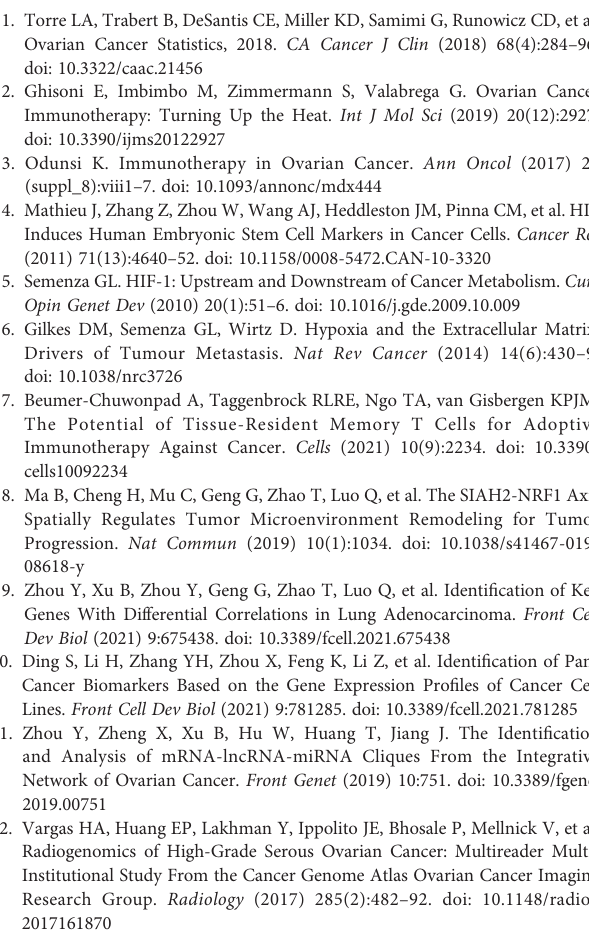
the TCGA cohort. (G) Calibration curve of nomogram for OS prediction at 1 year, 3 years, and 5-years in the GEO cohort. Supplementary Figure 2 | Heat map of different types of immune cells based on 6 algorithms. Supplementary Figure 3 | Predictive value of hypoxia risk score in the immunotherapy cohort. (A) Kaplan-Meier analysis of IMvigor cohort. (B) Analysis of differences in hypoxia risk score of different response. Supplementary Figure 4 | Drug sensitivity analysis in different risk groups. (A) IC50 levels of Bleomycin. (B) IC50 levels of Cisplatin. (C) IC50 levels of Paclitaxel. (D) IC50 levels of Docetaxel. (E) IC50 levels of Etoposide. (F) IC50 levels of Gemcitabine. Supplementary File 1 | DEGs in normoxia and hypoxia cultured cell lines. Supplementary File 2 | DEGs in different hypoxia patterns. Supplementary File 3 | The results of univariate Cox regression analysis in 770 reguators. Supplementary File 4 | The results of 1008 radiomics signatures in training and testing